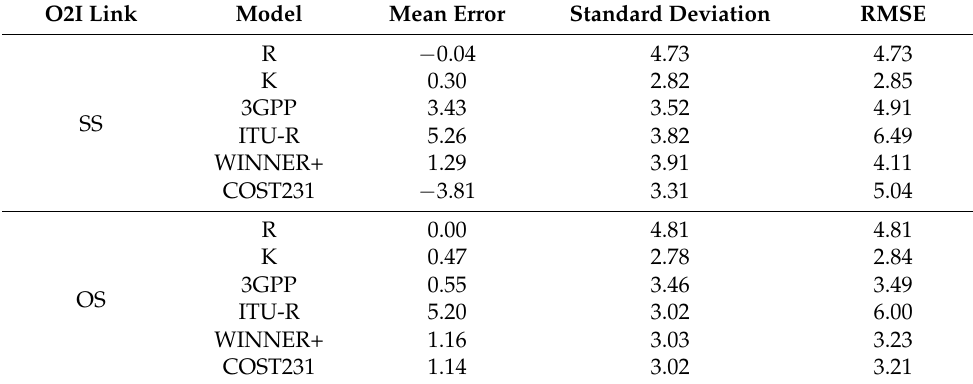
Table 6. Path Loss Models Accuracy.